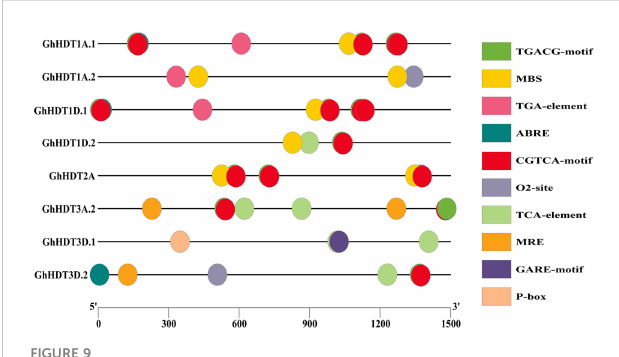
FIGURE 9 Results of investigation of the cis -regulatory elements of GhHD2 members. Micro-parts shown in distinct colors represent the sequence of the putative